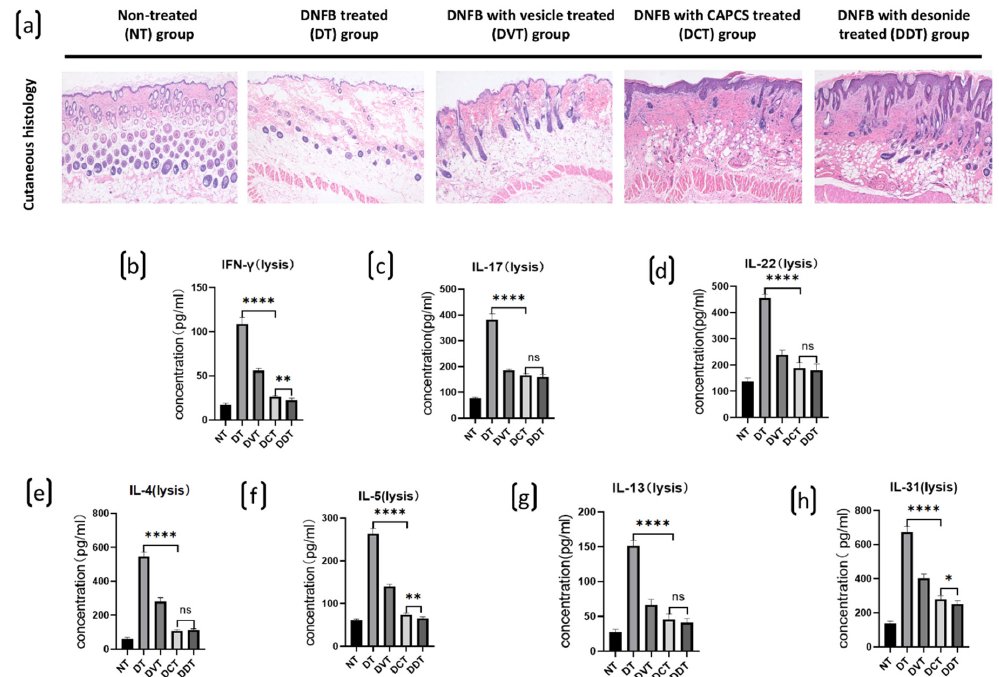
Figure 1. Cutaneous histology and expression of inflammatory cytokines of dorsal skin lesion of in each group of BALB/c mice. ( a ) Cutaneous histology of mice in each group: no hyperplasia or hyperkeratosis of epidermis, no infiltration of inflammatory cells was found in NT group; hyperkeratosis, dyskeratosis, and obvious inflammatory cell infiltration were found in DT and DVT groups; less inflammatory cell infiltration was shown in DCT and DDT groups (200×). ( b – h ) The expressions of inflammatory cytokines, including IFN-γ, IL-4, IL-5, IL-13, IL-31, IL-17, and IL-22, were increased significantly in DNFB-induced AD-like dorsal skin lesions in the DT, DVT, DCT, and DDT groups, in comparison to normal dorsal skin in NT group, and the levels of the cytokines expression were significantly decreased in the DCT and DDT groups, in comparison to the DT and DVT groups (data are presented as the mean ± S.E.M; ns: no significance, * p < 0.05, ** p < 0.01, and **** p < 0.0001).